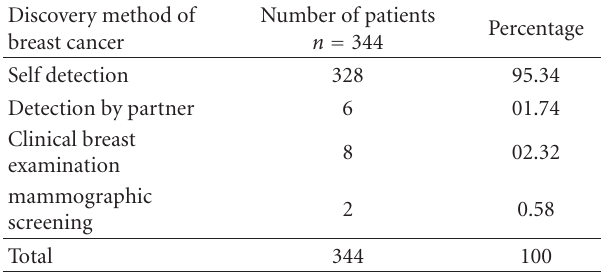
Table 2: Distribution of patients by discovery method of breast cancer.